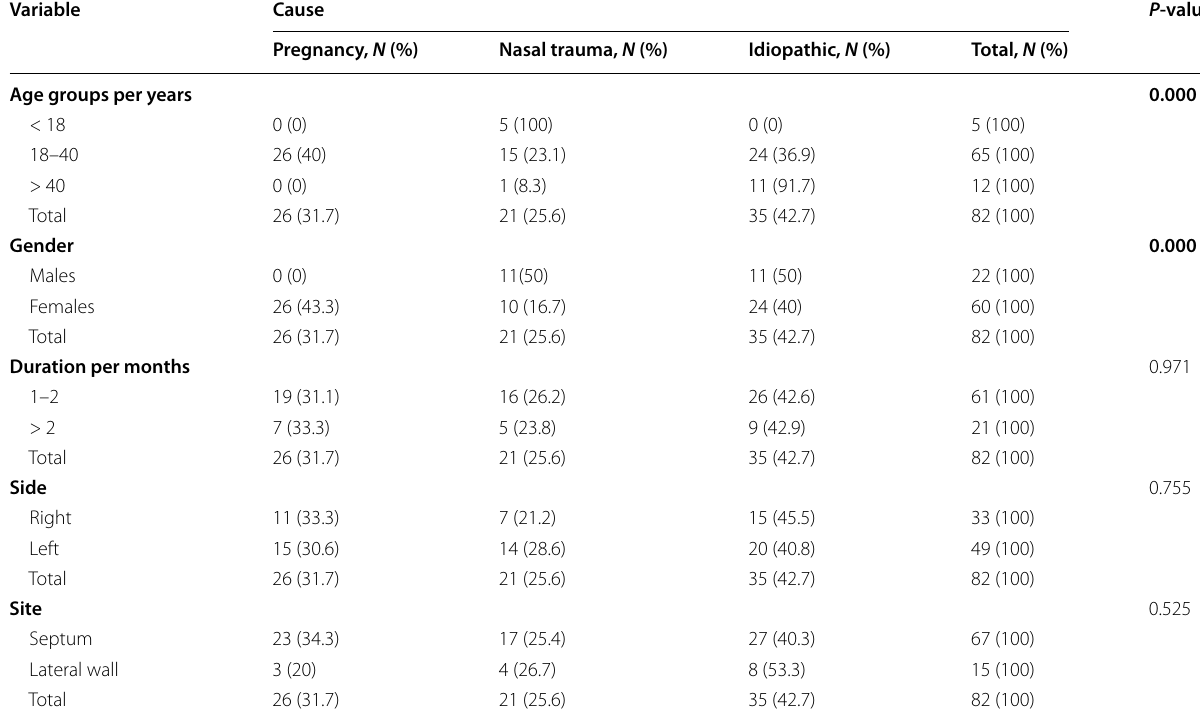
Table 2 The relationship between probable etiology and demographic and clinical factors in 82 individuals with intranasal LCH Variable